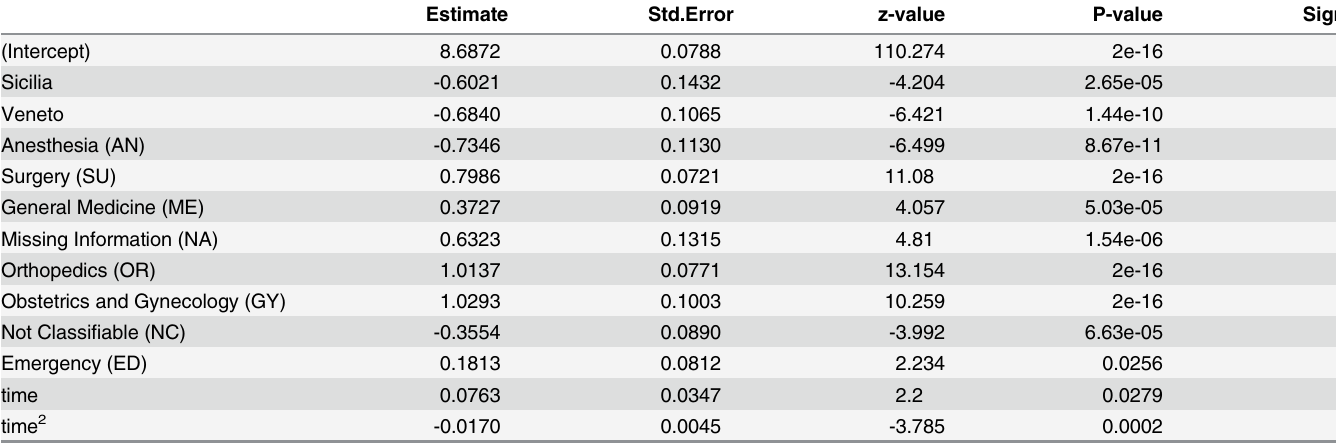
Table 19. Final model for Cost (payment), conditionally on its being greater than zero, for claims given by